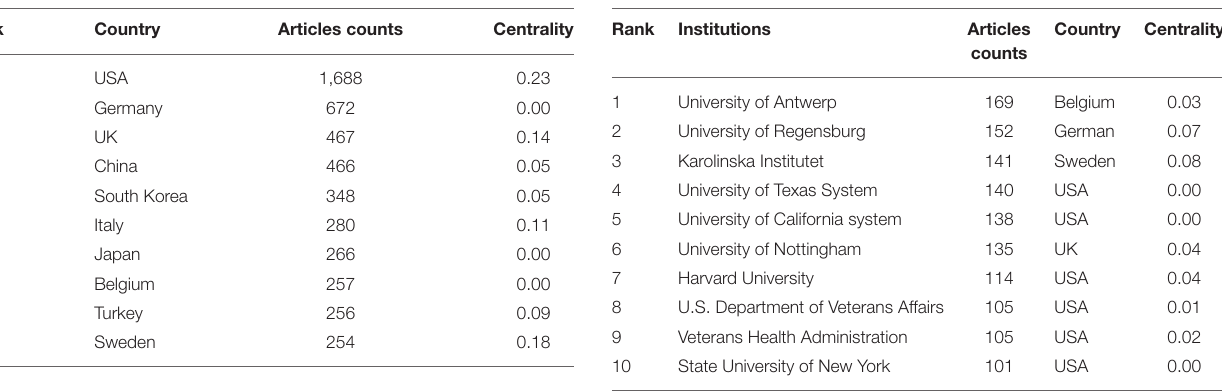
TABLE 2 | Ranking of top 10 institutions for collaboration in tinnitus research from 2001 to